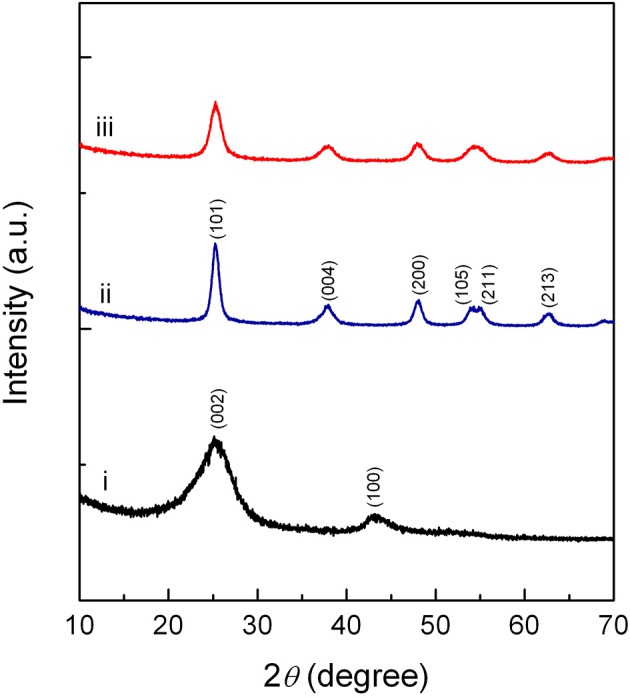
X-ray diffraction patterns of neat CNT (i), Pd-Cu/TiO2 (ii), and Pd-Cu/20CNT-TiO2 (iii).